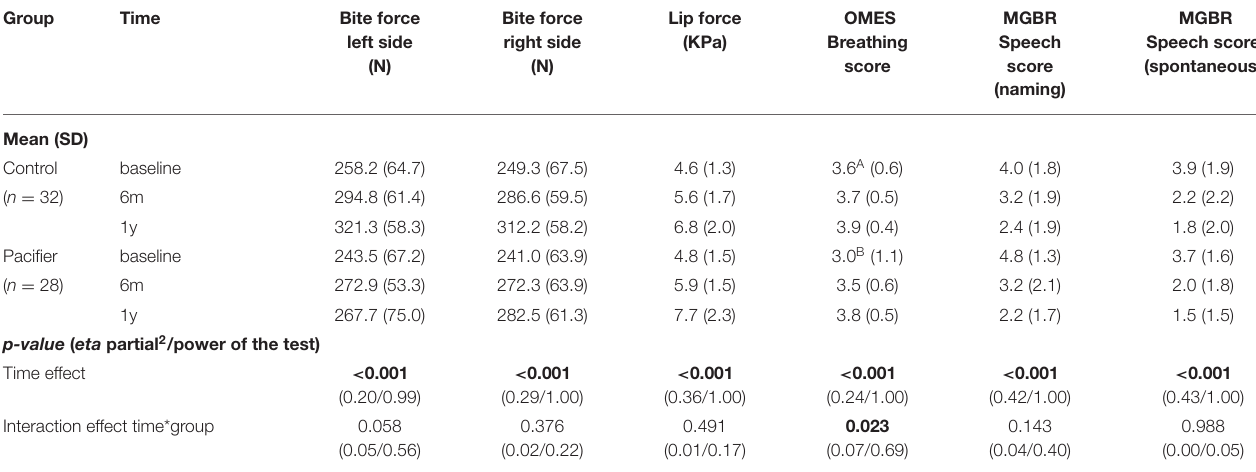
TABLE 3 | Interaction effect time*group on orofacial functional aspects: a Two-way Mixed Model. Group